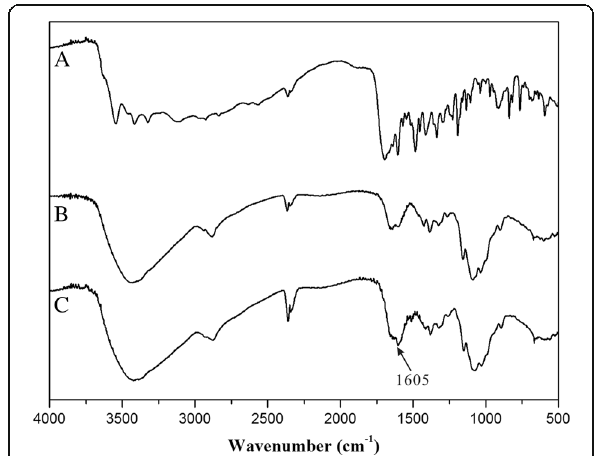
Fig. 2 FTIR spectra of ( a ) FA, ( b ) chitosan, and ( c )